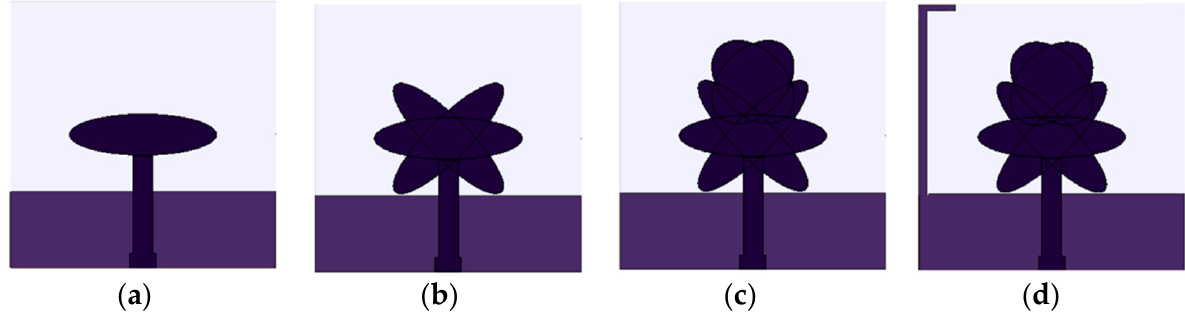
Figure 1. Proposed ultra-wideband (UWB) antenna ( a ) front view ( b ) back view.